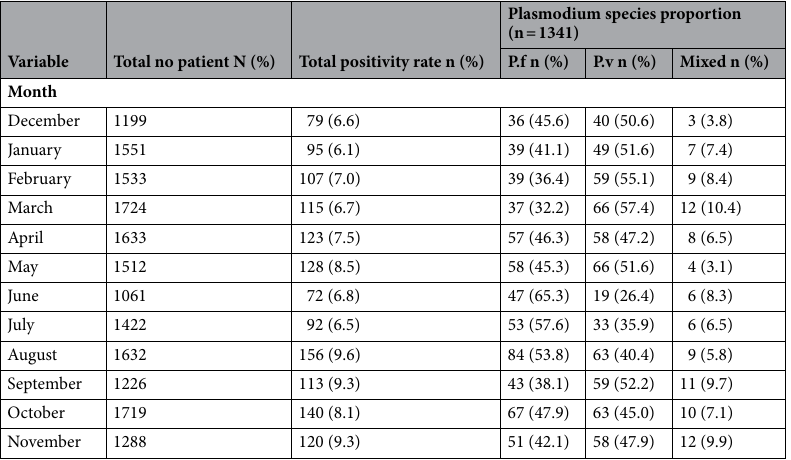
Table 4. Monthly prevalence of malaria and proportion of plasmodium species among patients requested for malaria examination at University of Gondar Specialized Referral Hospital from 2014 to 2019.